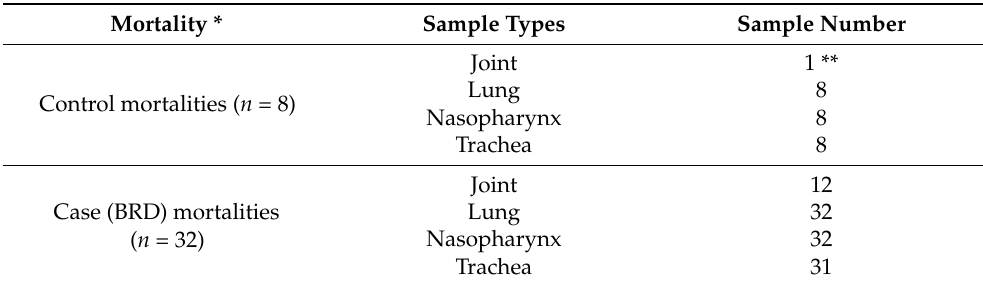
Table 1. Samples used to investigate comparative microbiota from two group of animals (control vs. case (BRD) mortalities). Mortality * Sample Types Sample Number